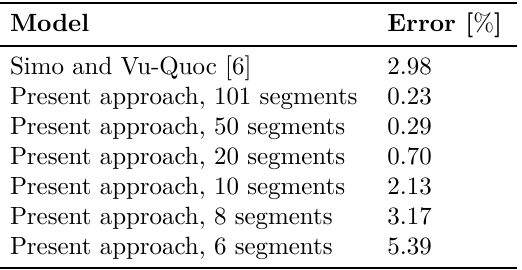
Table 1. Sum of the absolute values of the di ff erences between the exact and the computed displacement solutions calculated for the sixth load step. The model of Simo and Vu-Quoc [6] uses an eight-element mesh while the presented beam model uses one element with a variable number of segments of the integration scheme.